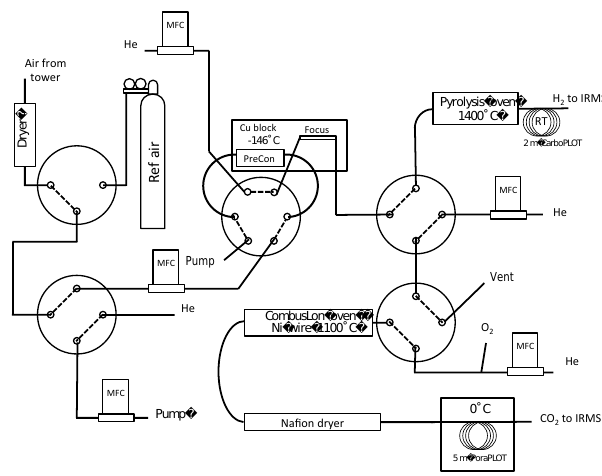
Figure 1. Schematics of the preconcentration and extraction system developed for the IRMS technique. MFC denotes mass flow con- troller. The eight-port valve through which the reference air cylin- der (Ref) was connected to the first selection valve is not shown to reduce complexity. For further description see the main